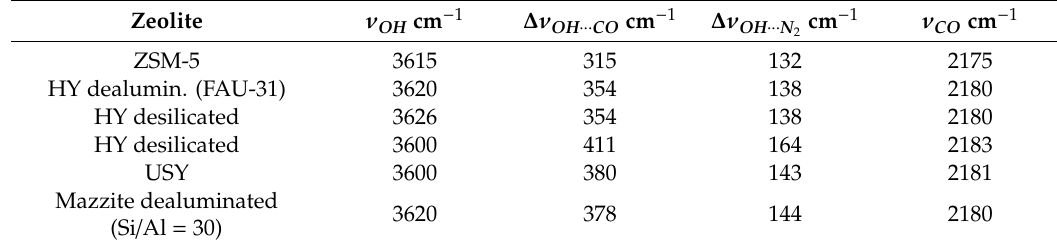
Table 5. The data on the acid strength of OH groups in zeolites: the frequency shifts of OH bands interacting with CO ( ∆ ν OH ··· CO ) and with N 2 ( ∆ ν OH ··· N ), the stretching frequency of CO molecule 2 interacting with OH groups. The data were adapted (with the permission) from